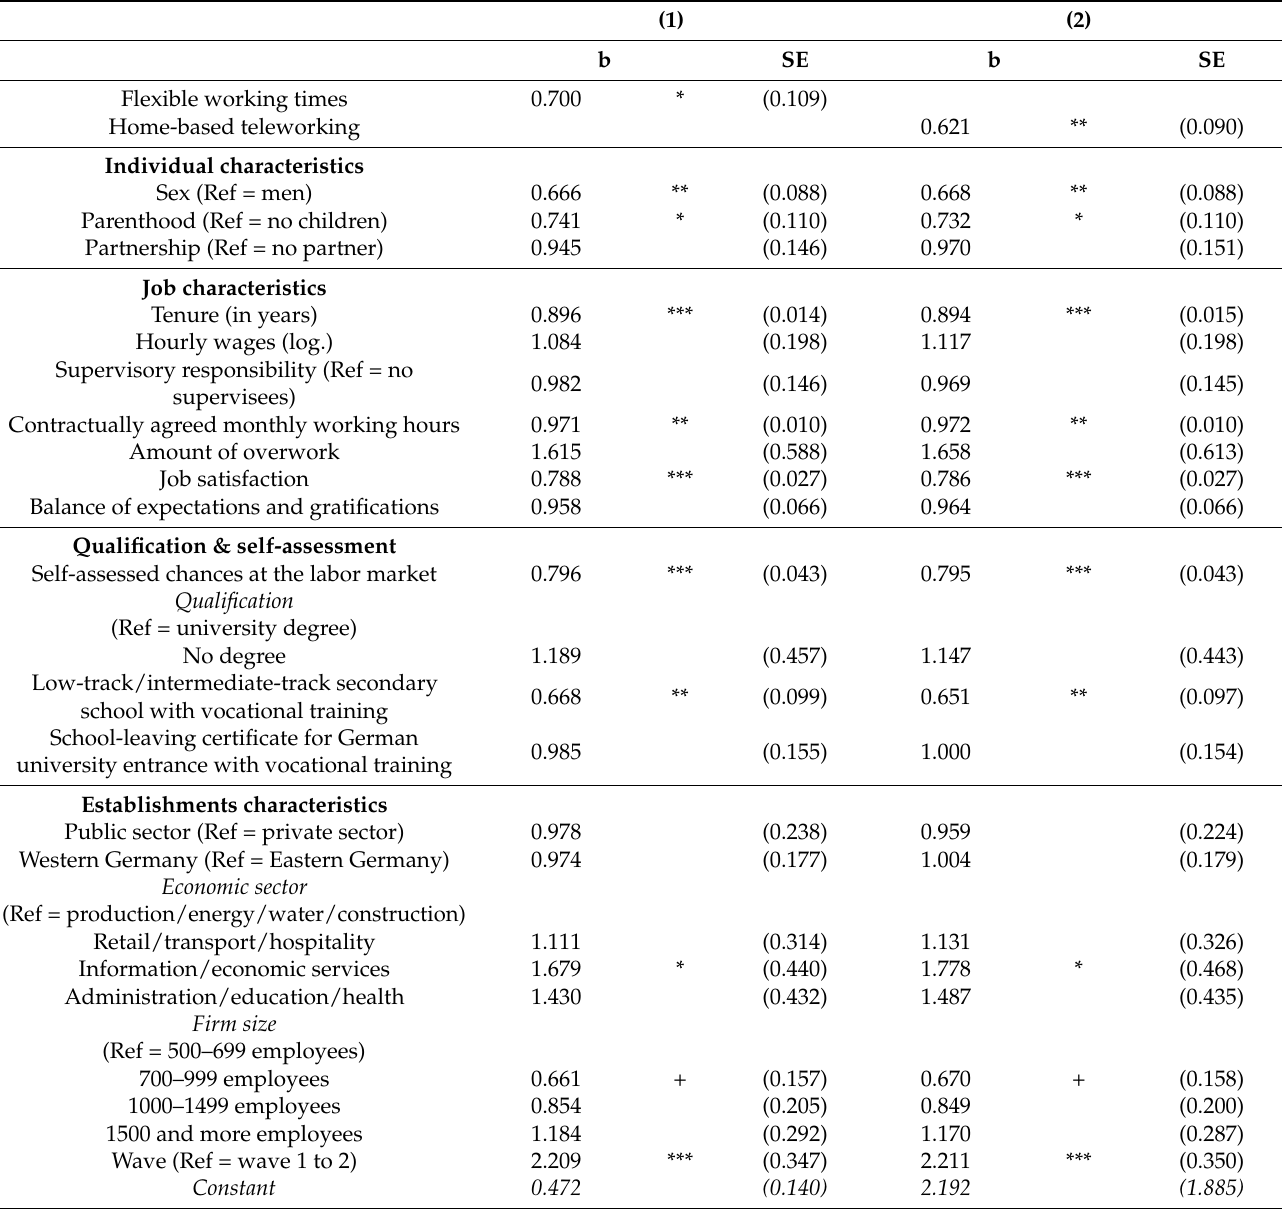
Table 2. The effect of flexibility measures on voluntary employee exit (logistic regression with organizational mixed effects and clustered standard errors; odds